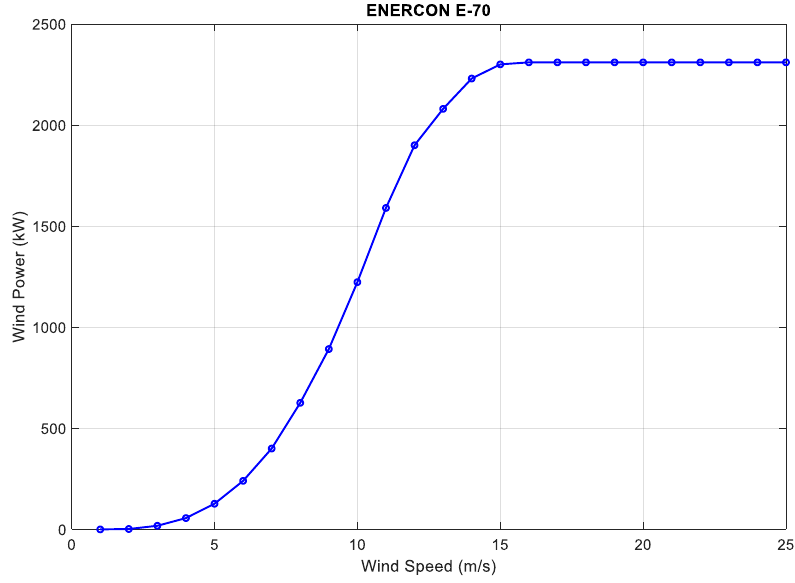
Figure 5. Variable-speed wind turbine power curve.